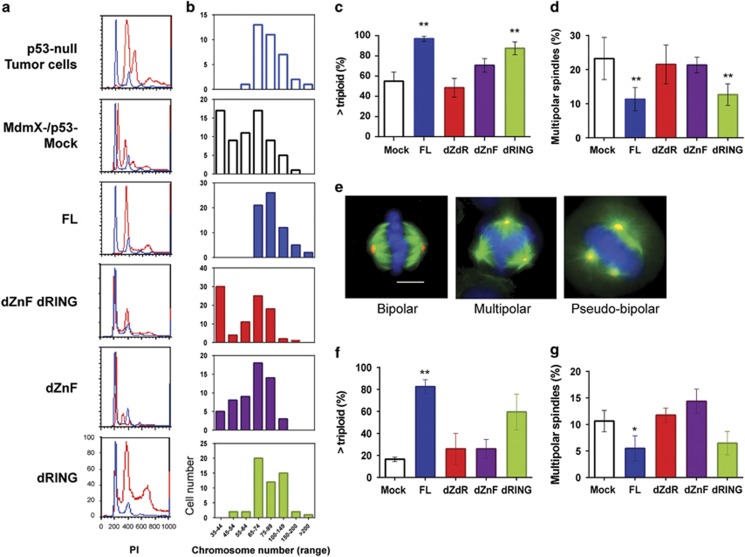
Zn-finger domain of MdmX suppresses genome instability in mouse tumor cells. (a) DNA content of MdmX/p53-double knockout (DKO) mouse tumor cells transduced with MdmX FL or deletion mutants determined by propidium iodide staining. DNA content of experimental cells (red histograms) was superimposed over the DNA content of parental non-transduced MdmX/p53-null cells (blue histograms). (b) Metaphase spread analysis for chromosome number per cell (in indicated ranges) in MdmX-transduced DKO cells. The results are from representative experiment with at least 50 metaphase cells scored per cell line. (c) Summary of chromosome analyses showing cell fraction with larger than triploid genome in population of transduced DKO cells. Error bars represent mean±s.d. from two to four independent experiments with more than 50 metaphase cells scored per cell line per experiment. (d) Frequency of multipolar spindles as a percent of total mitotic events in the populations of MdmX-transduced DKO cells. More than 200 mitotic spindles were scored per experiment. Error bars represent mean±s.d. from three independent experiments. (e) Representative imunofluorescence images of DKO cells illustrating mitotic spindle organization. Cells were stained for alpha-tubulin (green), gamma-tubulin (red) and DNA (4′-6-diamidino-2-phenylindole, blue). Scale bar, 10 μm. (f) Chromosome analyses showing cell fraction with larger than triploid genome in population of MdmX-transduced MdmX/Mdm2/p53-triple knockout (TKO) mouse tumor cells. Error bars represent mean±s.d. from two independent experiments with at least 50 metaphases scored per cell line per experiment. (g) Frequency of multipolar spindles expressed as a percent of total mitotic events in the populations of transduced TKO cells. Error bars represent mean±s.d. from two to three independent experiments. P-values relative to Mock control: **P<0.005; *P from 0.005 to 0.05, unpaired t-test.